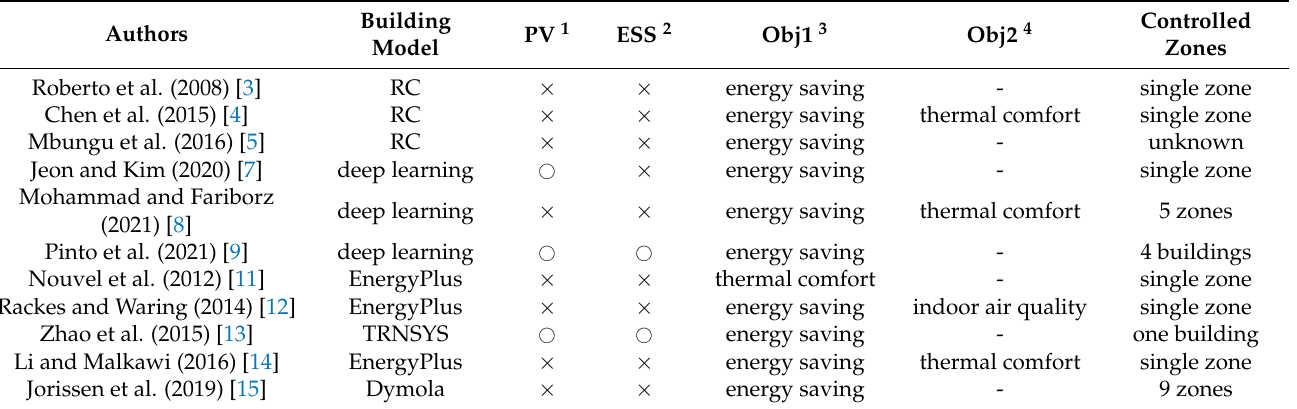
Table 1. Preceding model predictive control (MPC) research and investigations according to existing building models in the